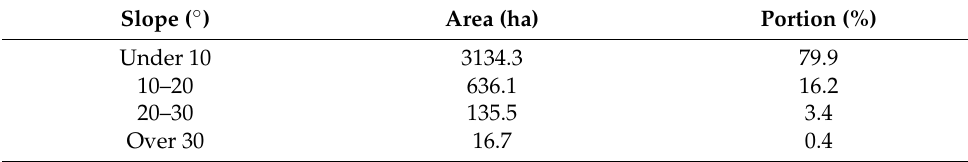
Figure 16. Terrain slope in Liberec Region. Table 4. Portions of area in railway protected zone in categories of